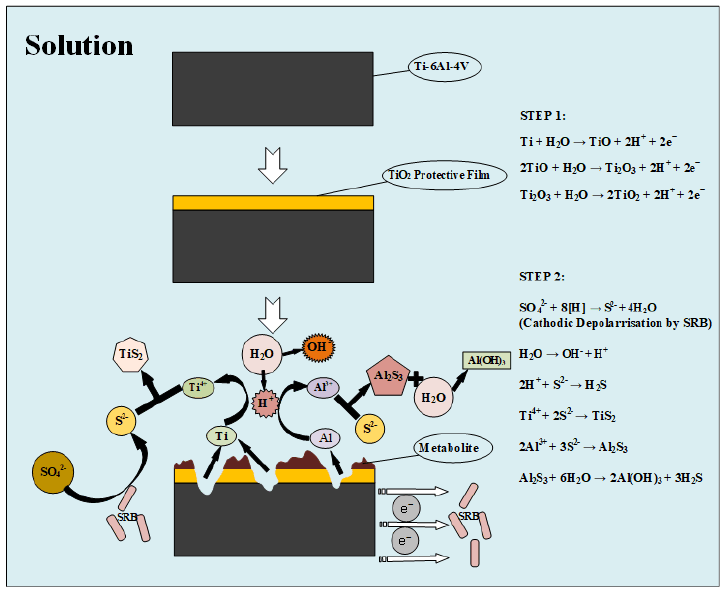
Figure 9. Schematic illustration of a probable mechanism of Ti–6Al–4V alloy corrosion by SRB.